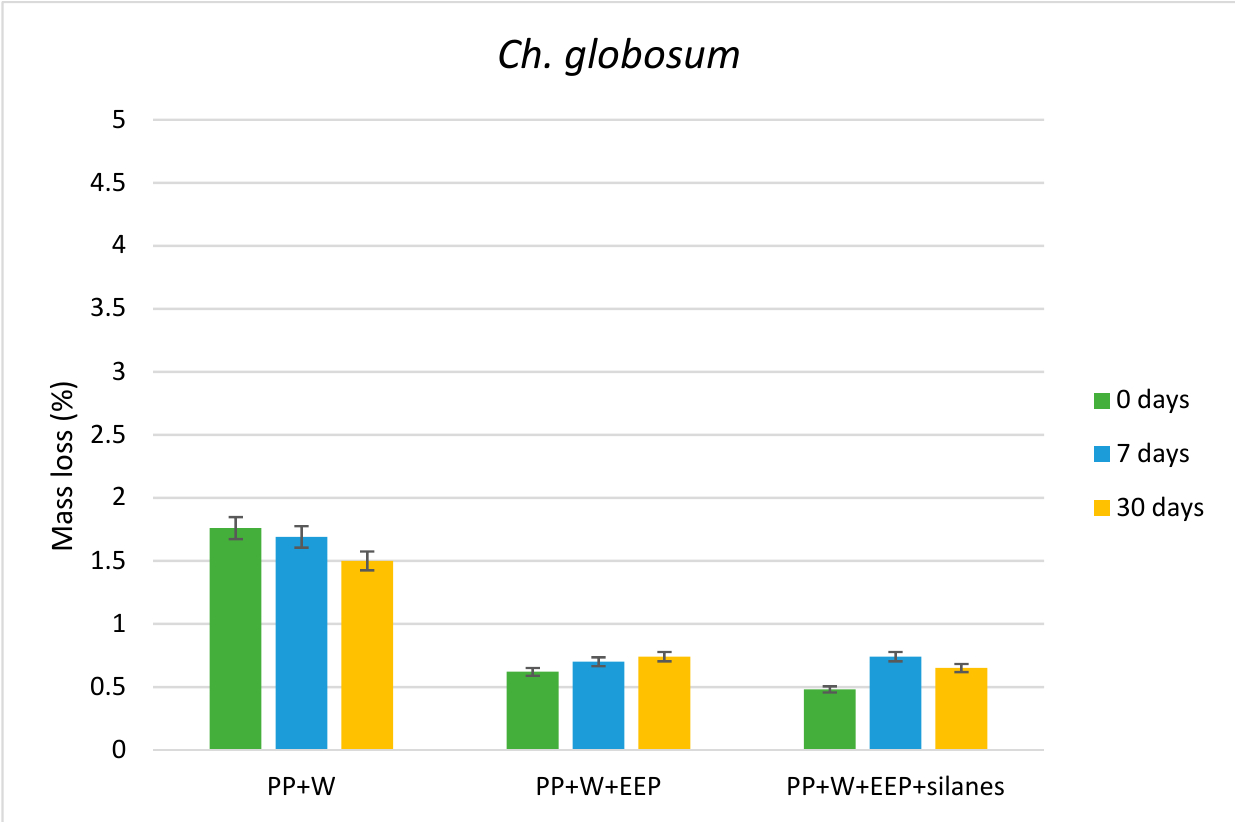
Figure 4. Mass loss of composites after exposure to Ch. globosum .